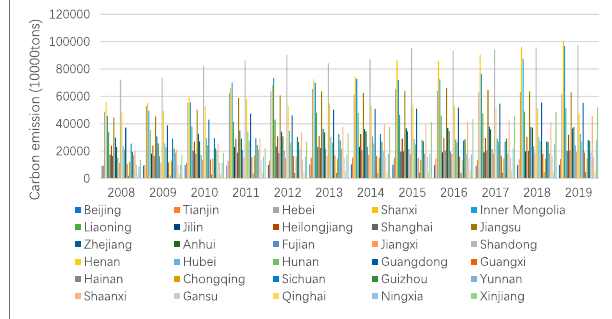
FIGURE 1 | Carbon emission of 30 provinces in China,2008 –